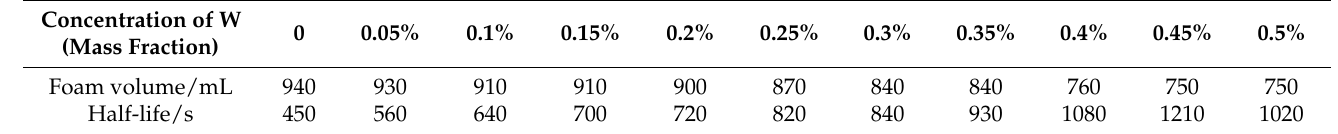
Table 2. Foam amount and half-life of W at different concentrations.